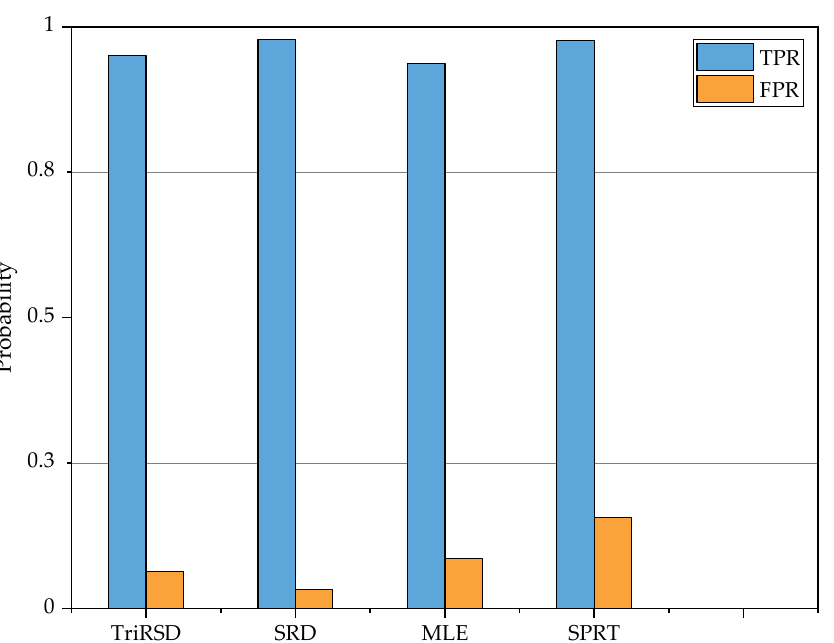
Figure 8. Average detection (TPR) and false alarm probabilities (FPR) for different algorithms applied to six IRSS datasets. Reprinted, with permission, from [89]. © 2021